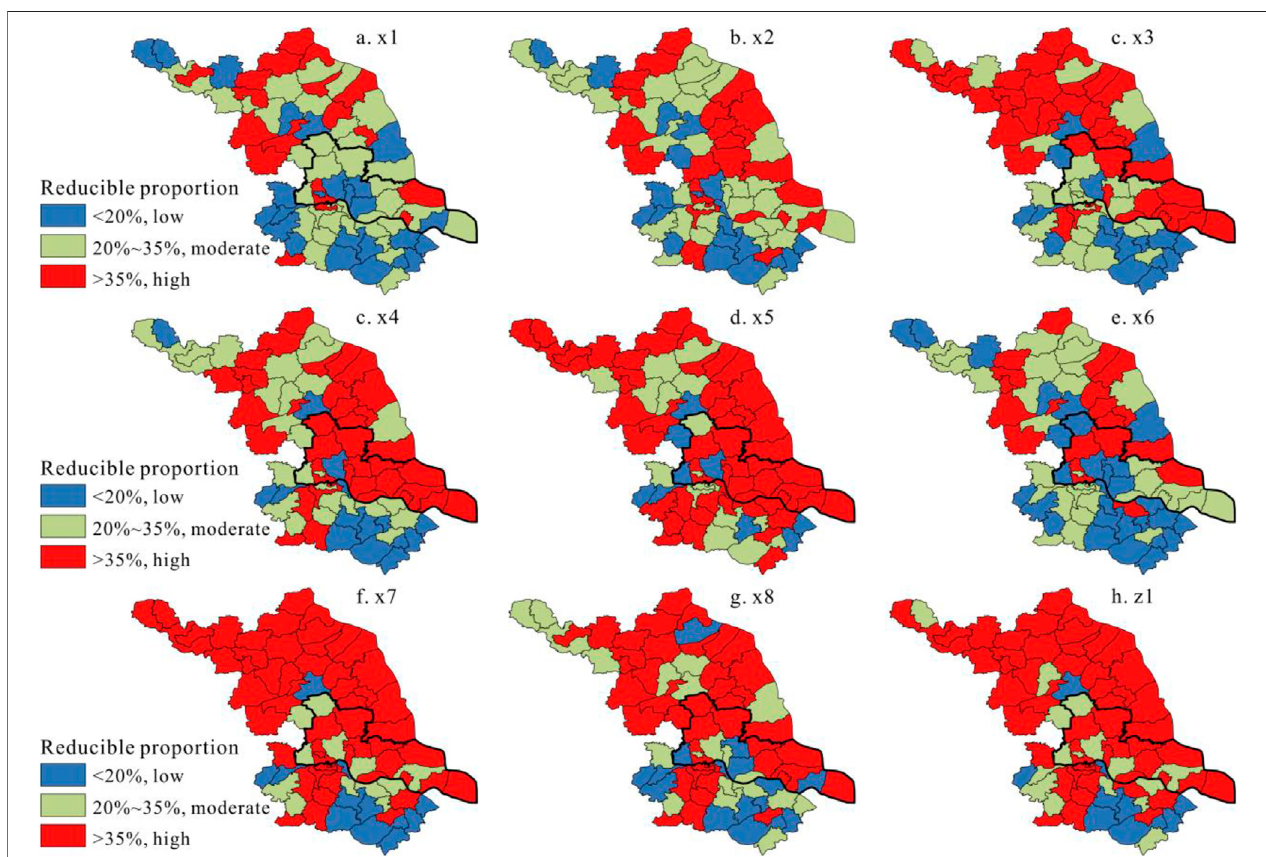
FIGURE 7 | The improvement potential for agricultural ecological ef fi